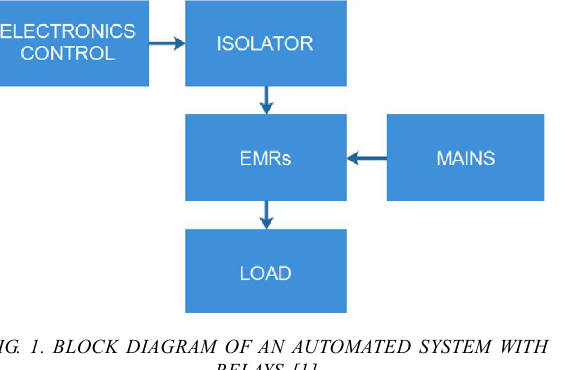
FIG. 1. BLOCK DIAGRAM OF AN AUTOMATED SYSTEM WITH RELAYS